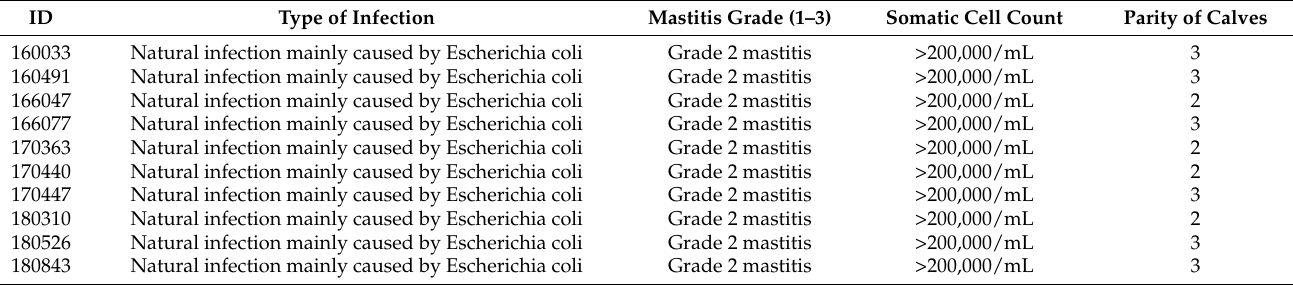
Table 4. Mastitis